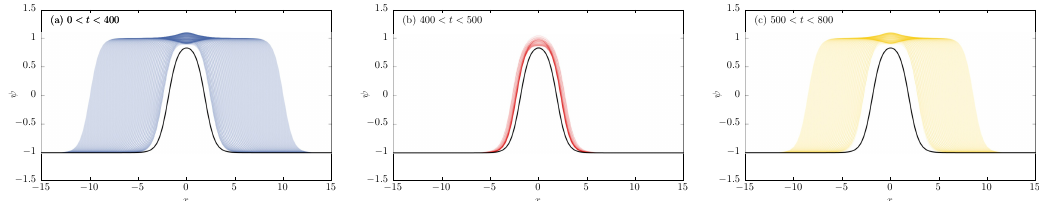
Figure 11 . Evolution of the field ψ obtained in the scattering of the initial configuration (5.1)–(5.2) with the purple mode ( n = 6) initially excited. Here A = 0 . 095 and solitons are back scattered before the